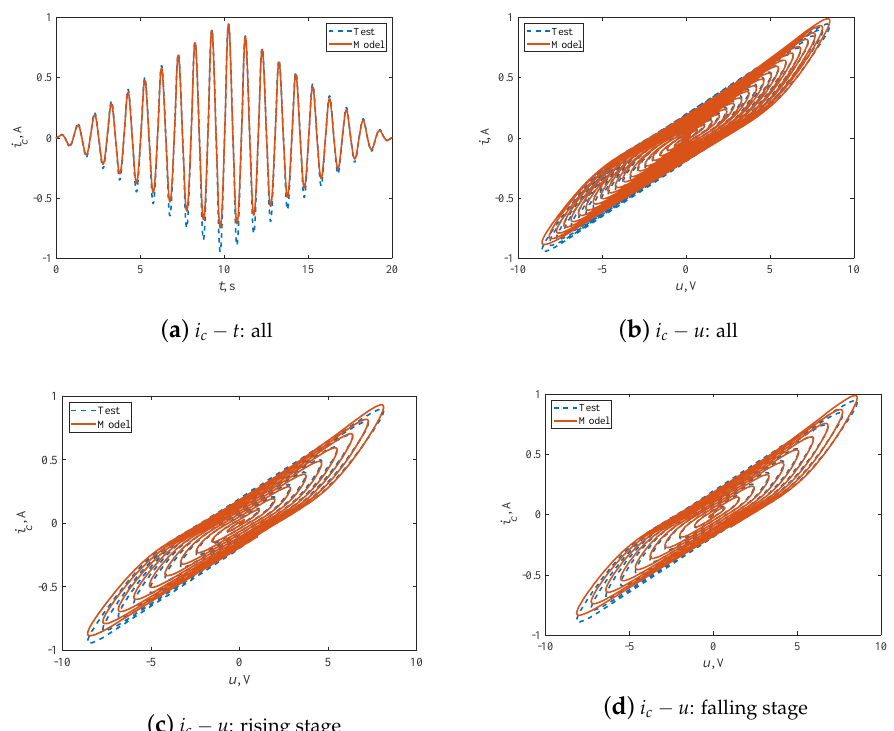
Figure 8. Current response to time-varying amplitude voltage.